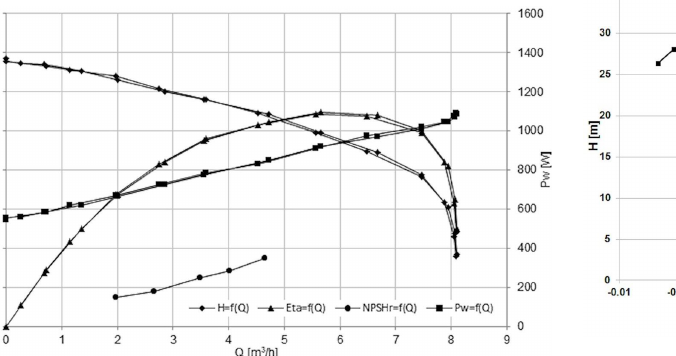
Figure 12: Cavitation curves of the Impeller 4